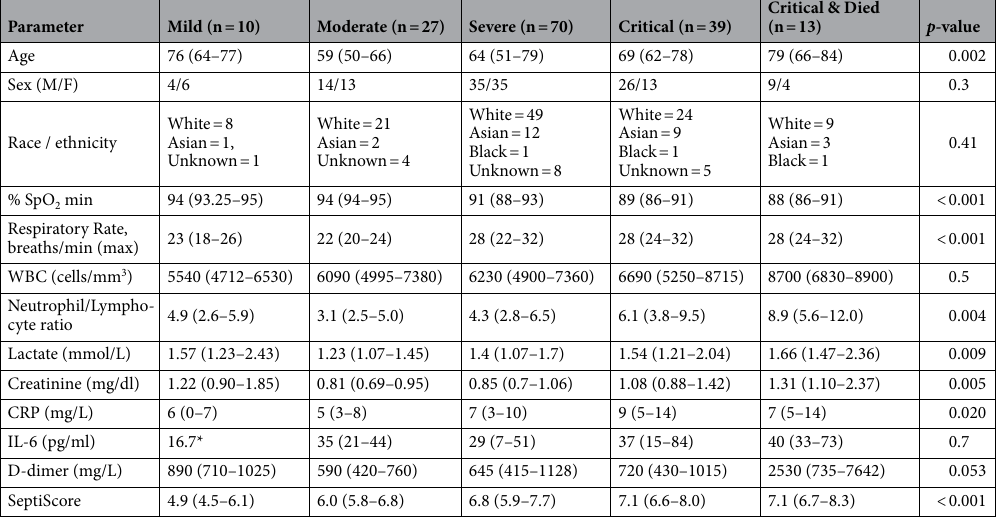
Table 2. Demographic and Clinical characteristics of patients stratified by COVID severity. The severity categories were defined according to the WHO COVID-19 Guidance 2021 19 . There were 146 patients in this cohort. Recorded values are medians (interquartile ranges). p -values were calculated with one-way ANOVA. [*IL-6 was measured for only one Mild patient, so IQR could not be